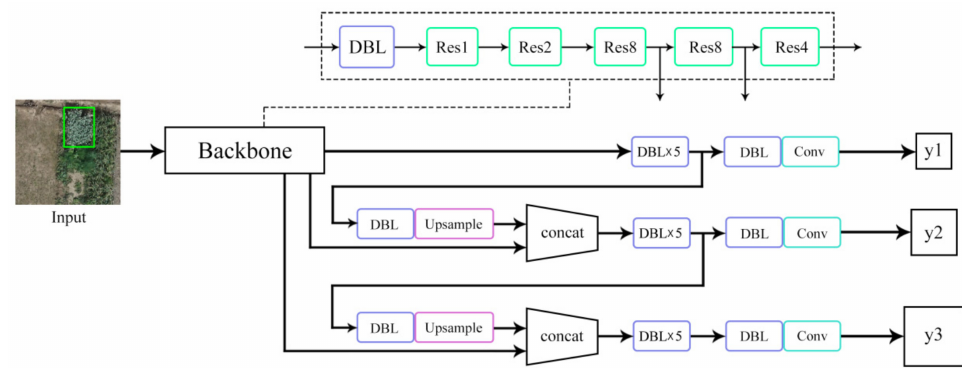
Figure 4. The original network structure of